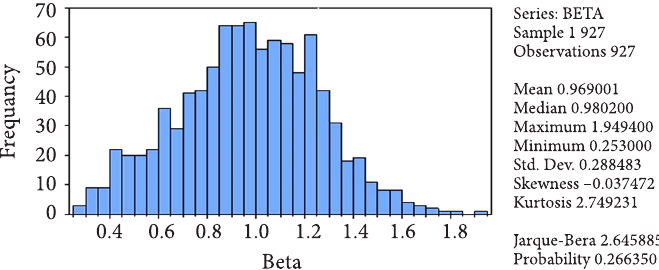
Figure 2. The frequency distribution graph and summary of statistics of the pre-repurchase beta